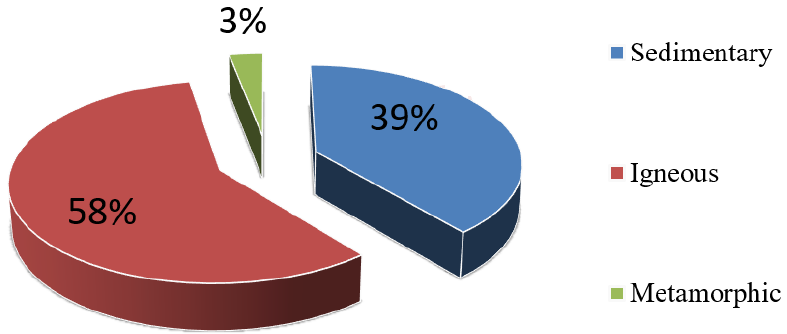
Figure 2. Context-type ratio of Iranian rock-cut buildings.